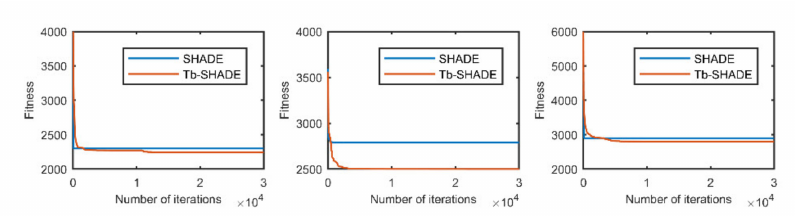
Figure 3. The selected average convergence of SHADE and Tb-SHADE is compared on CEC2020 in 15 D . From left to right f8, f9 and f10.